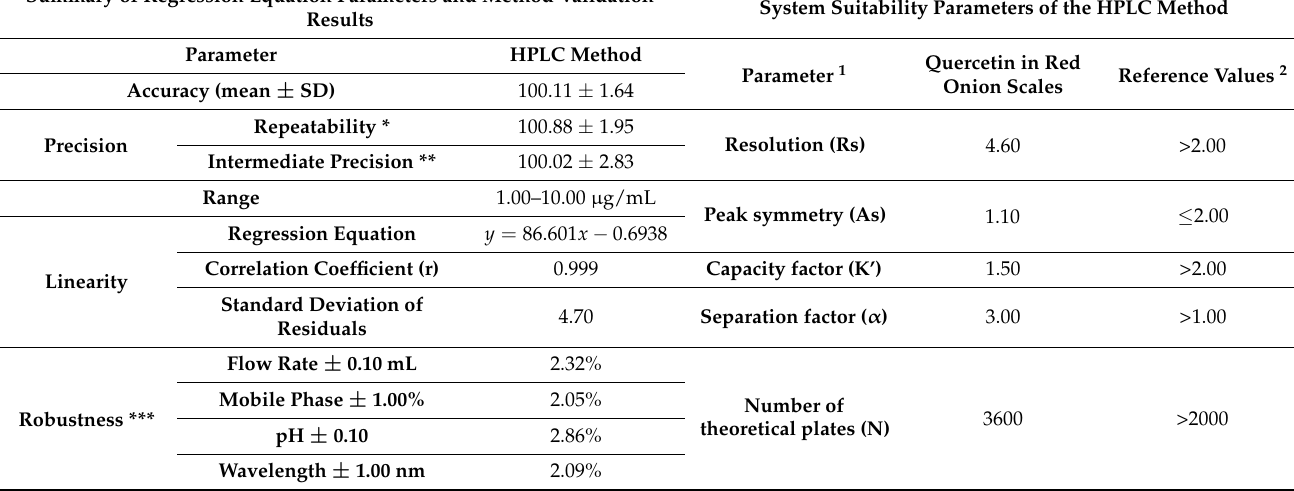
Table 1. Summary of regression equation parameters and method validation results for quercetin standard collected by the proposed HPLC and system suitability parameters for HPLC method of analysis. Summary of Regression Equation Parameters and Method Validation